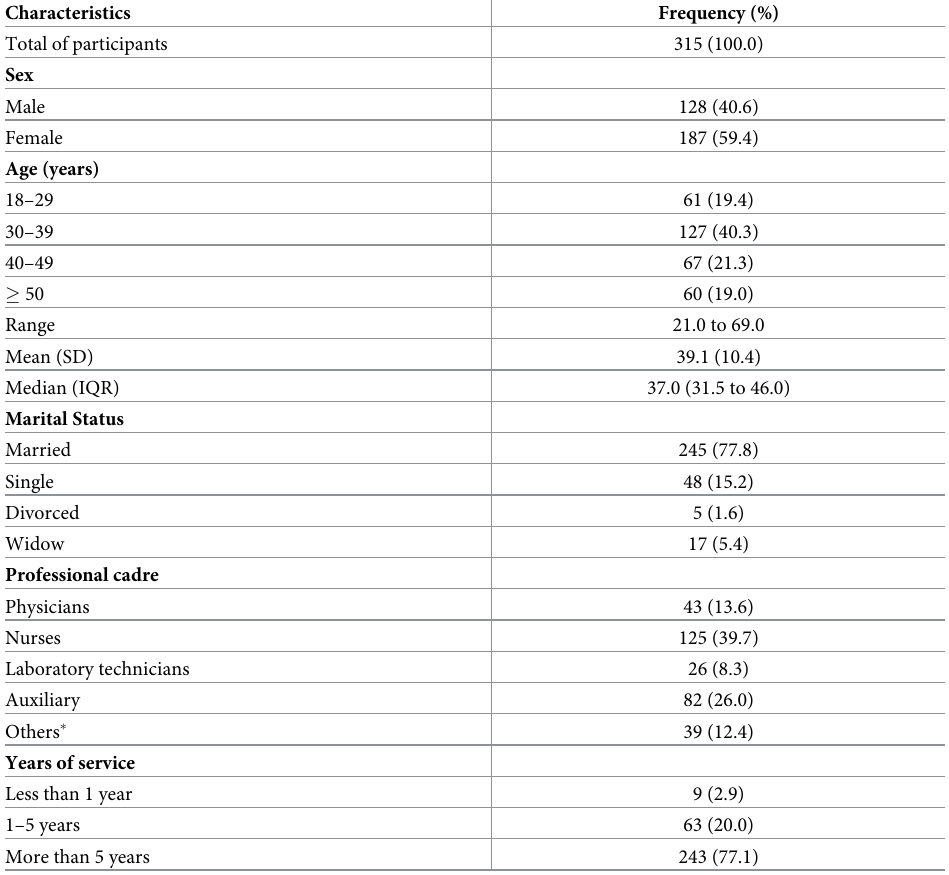
Table 1. Sociodemographic characteristics of the study